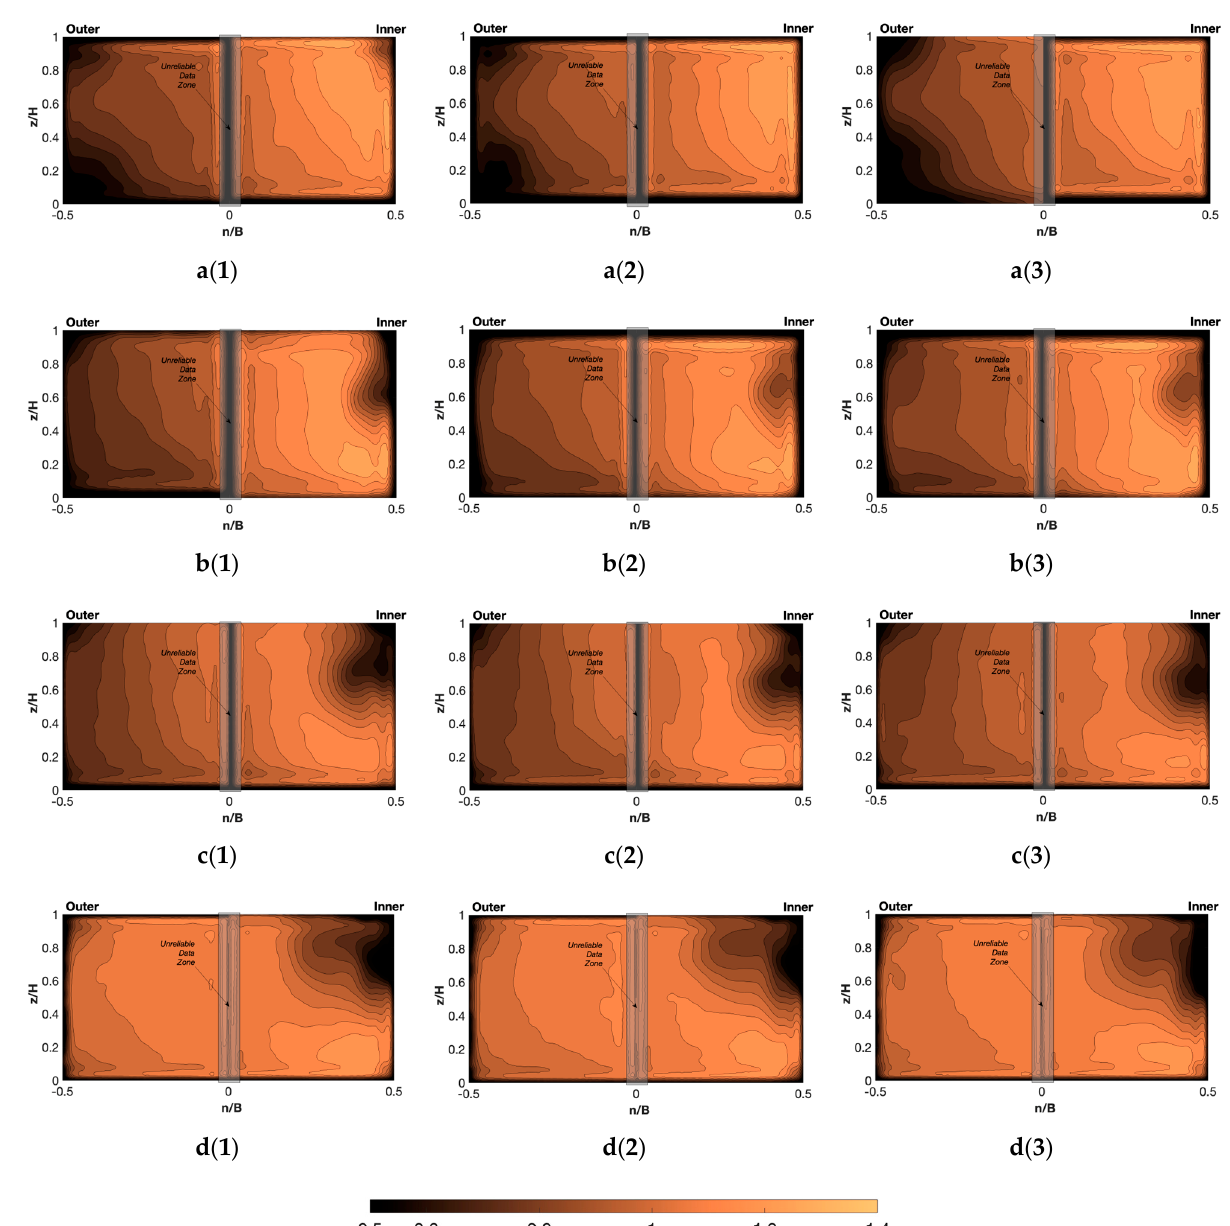
Figure 4. Streamwise velocity distribution at the measured cross-sections: ( a ) 37 degrees; ( b ) 90 de- grees; ( c ) 105 degrees; ( d ) 125 degrees. The numbers 1, 2, and 3 denote different jet conditions (1) S = 3.5; (2) S = 10; (3) S =